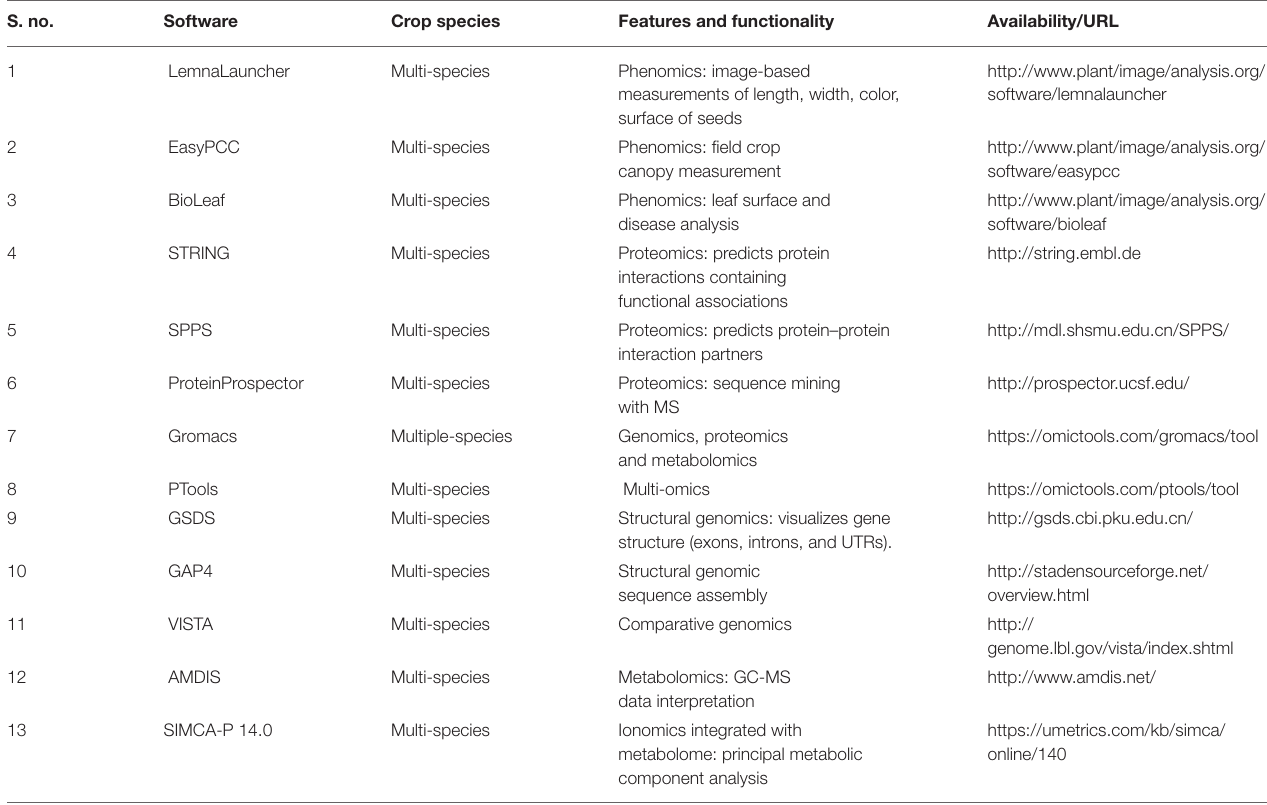
TABLE 2 | List of online software packages used for crop multi-omics analysis. S.